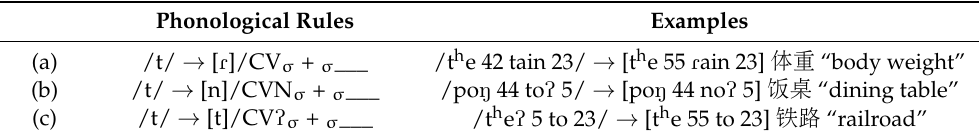
Table 1. Onset change pattern after different types of syllables in Xiapu Min *.